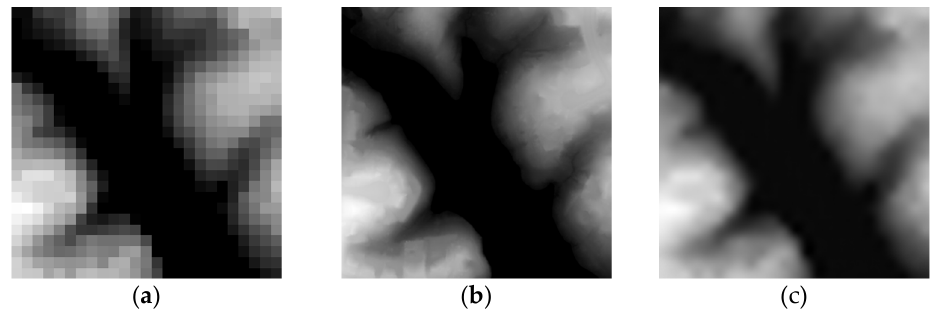
Figure 6. ( a ) Low-resolution DEM, ( b ) high-resolution DEM, and ( c ) generated high-resolution DEM by DSRGAN.